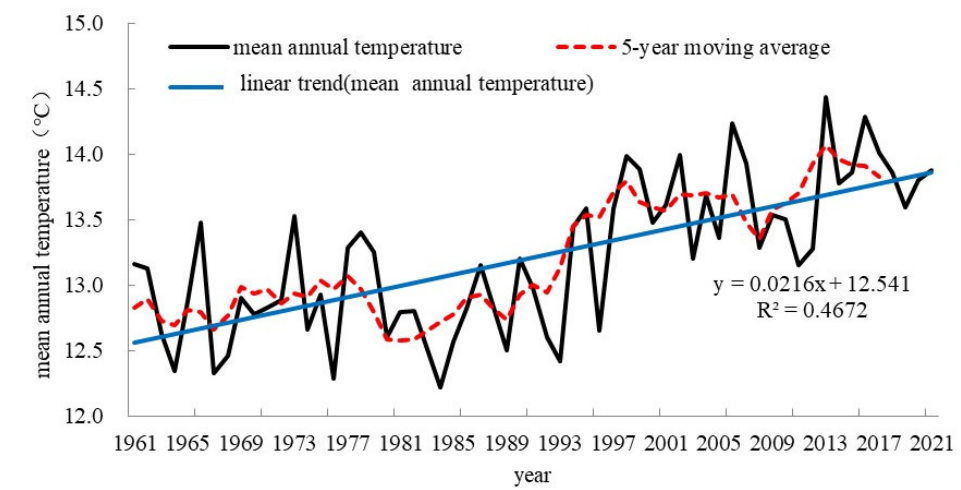
Figure 2. Time series of regionally averaged annual mean temperature (AMT) (unit: °C) from 32 stations in the QMs during the period 1961–2021. The black line denotes the temperature curve, the red dashed line denotes the 5-year moving average curve, and the blue line denotes the linear trend curve.